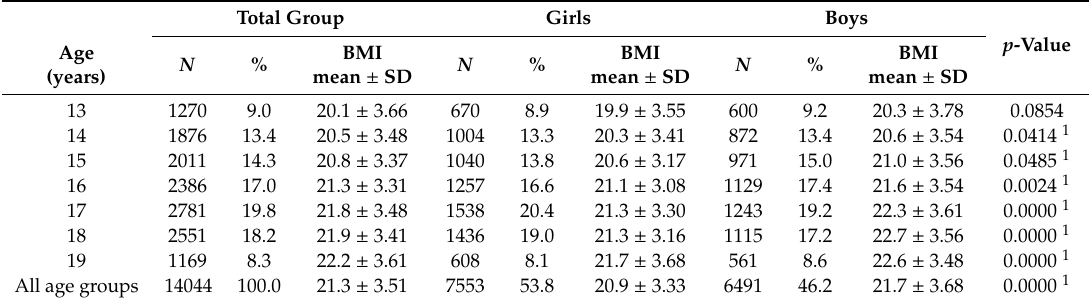
Table 1. Age and body mass index (BMI) distribution of the individuals: In the total group and divided by